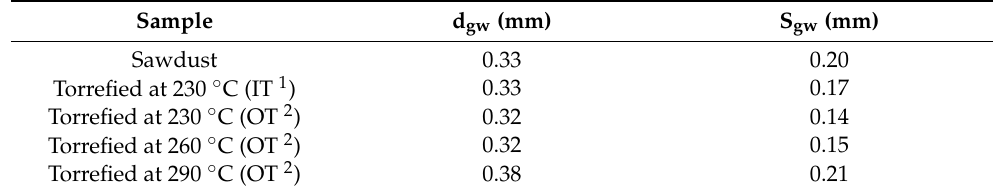
Table 3. Geometric mean diameter (d gw ) and geometric standard deviation (S gw ) of non-treated and treated sawdust particles.